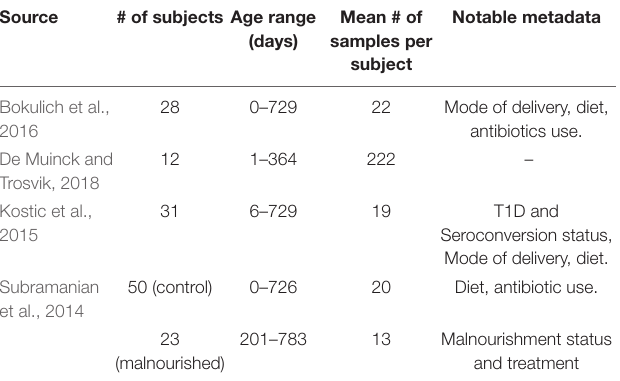
TABLE 1 | Data sources included in the